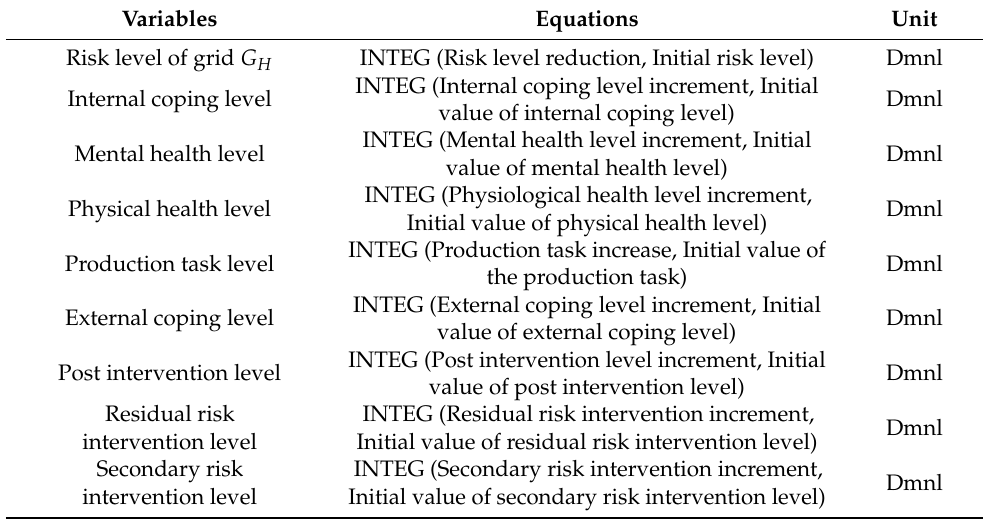
Table 4. Equation expression of grid G H .